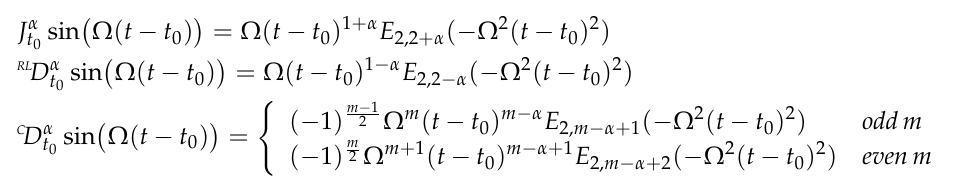
Figure 6. Comparison of RL D α ( left plot ) and α = 1.7 ( right plot